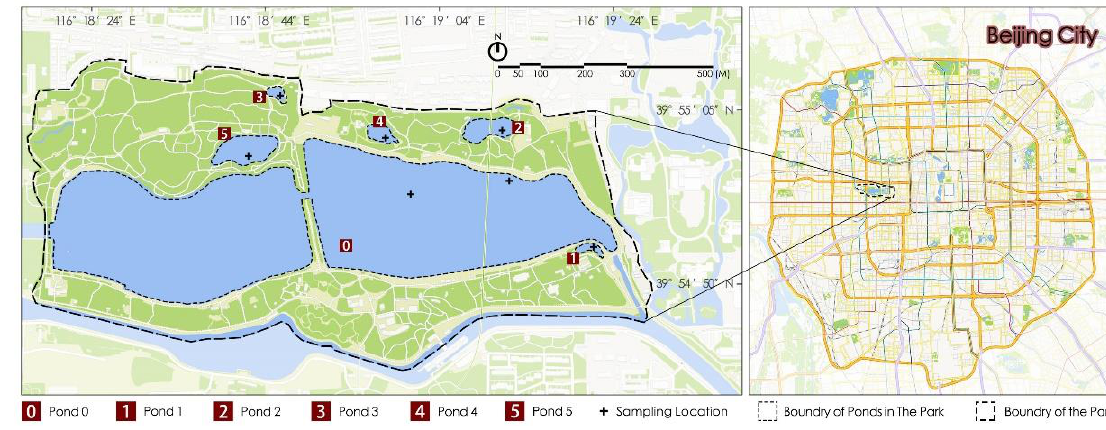
Figure 1. Ponds and sampling locations. Table 1. Description of each